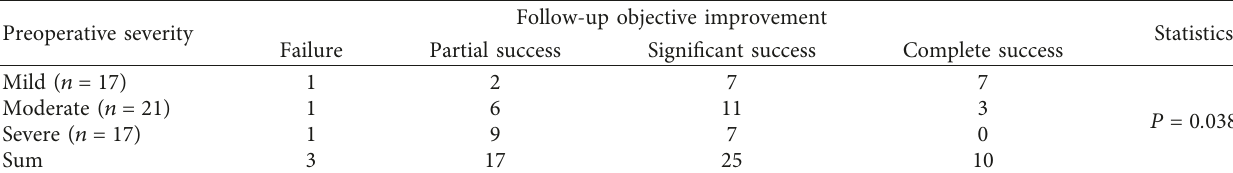
Figure 2: Floater shadow areas in fundus IR images before YAG and at 6-month follow-up. (a) Changes of floater shadow areas in fundus IR images. (b) Floater shadow areas in eyes with different preoperative severities. (c) Decrease percentage of floater shadow areas in eyes with different preoperative severities. Table 3: Follow-up improvement evaluating by floater shadow areas in fundus IR